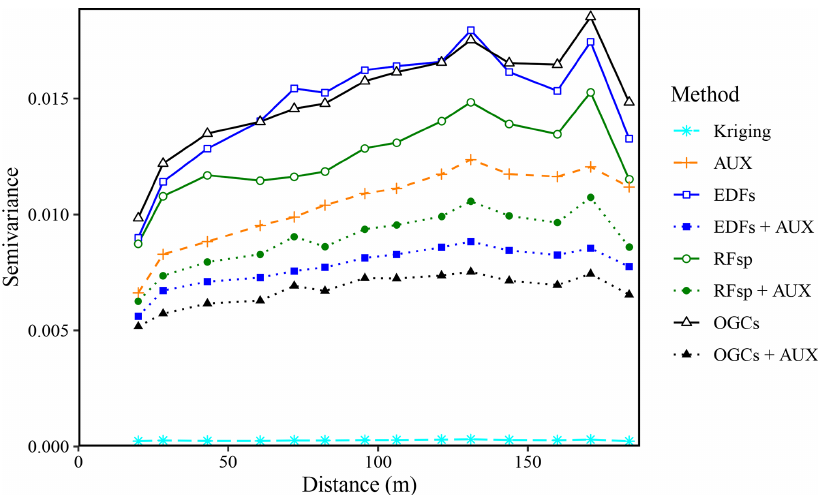
Figure 12. Experimental variograms for the residuals of the SOM predictions made with each method for the Vindum dataset. The variograms use residuals from natural logarithmic-transformed SOM measurements and predictions. AUX – auxiliary data; EDFs – Euclidean distance fields; RFsp – spatial random forest; and OGCs – oblique geographic coordinates.